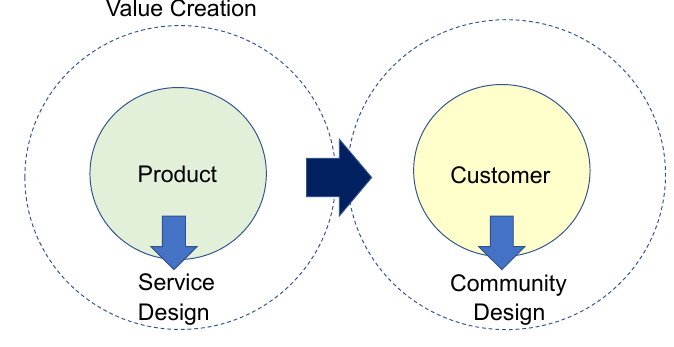
Figure 1. Creating new value and capturing